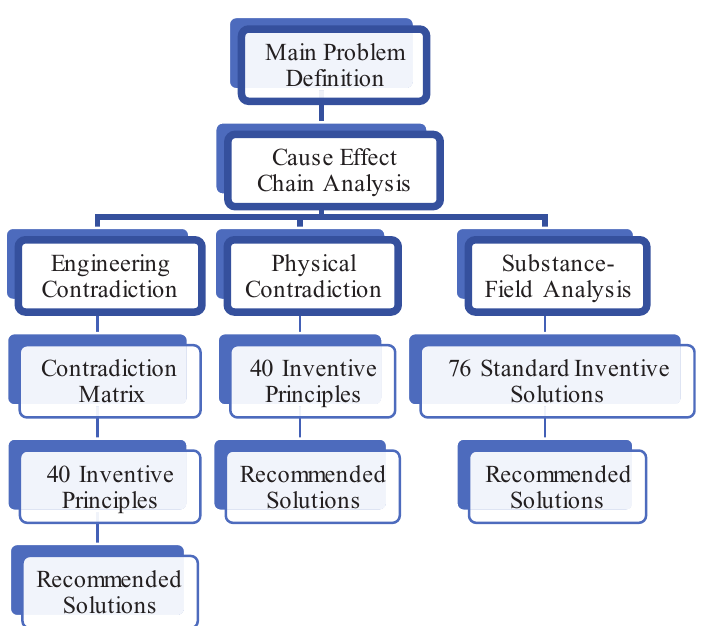
Figure 2. Theory of inventive problem-solving (TRIZ) framework used in this research project.